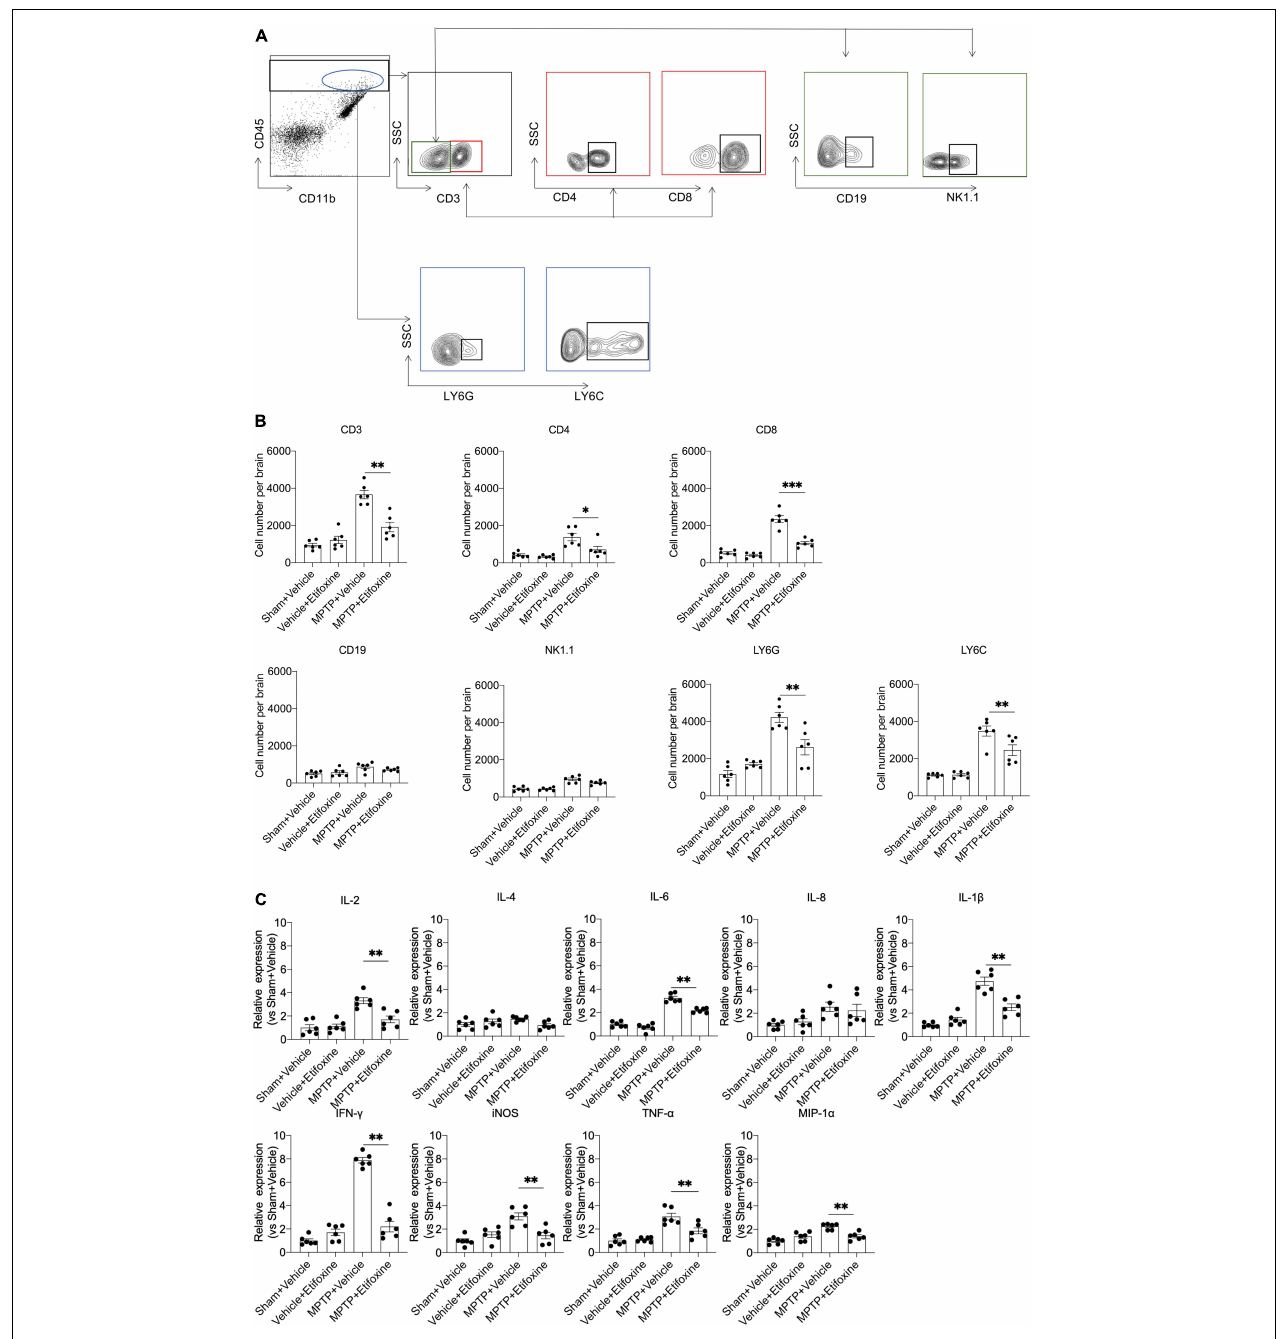
FIGURE 4 | Etifoxine decreased leukocyte infiltration and brain inflammation following MPTP treatment. C57BL/6 mice were administered etifoxine or vehicle immediately after saline or MPTP administration. After day 7, suspensions were prepared from substantia nigra and striatal tissues. (A) Flow cytometry plots showing the gating strategy for infiltrating leukocyte subsets, including T cells (CD45 high CD3 + ), CD4 + T cells (CD45 high CD3 + CD4 + ), CD8 + T cells (CD45 high CD3 + CD8 + ), B cells (CD45 high CD3 - CD19 + ), NK cells (CD45 high CD3 - NK1.1 + ), macrophages (CD45 high CD11b + LY6C + ), and neutrophils (CD45 high CD11b + Ly6G + ). (B) Quantification of infiltrating lymphocytes, macrophages, and neutrophils in the groups of mice receiving the indicated treatments. T cells: F (3,20) = 36.01, P < 0.001; CD4 + T cells: F (3,20) = 12.48, P = 0.01; CD8 + T cells: F (3,20) = 66.51, P < 0.001; B cells: F (3,20) = 4.483, P = 0.51; NK cells: F (3,20) = 24.73, P = 0.09; macrophages: F (3,20) = 32.11, P = 0.009; neutrophils: F (3,20) = 25.53, P = 0.002, ∗ P < 0.05, ∗∗ P < 0.01. (C) Bar graphs showing the mRNA expression of IL-2, IL-4, IL-6, IL-8, IL-1 β , TNF- α , MIP-1 α , iNOS, and IFN- γ in substantia nigra and striatal tissues from groups of mice receiving the indicated treatment. IL-2: F (3,20) = 17.61, P = 0.001; IL-4: F (3,20) = 2.701, P = 0.086; IL-6: F (3, 20) = 96.75, P < 0.001; IL-8: F (3,20) = 4.170, P = 0.94; IL-1 β : F (3,20) = 43.86, P < 0.001; TNF- α : F (3, 20) = 20.50, P = 0.003; MIP-1 α : F (3,20) = 17.81, P < 0.001; iNOS: F (3,20) = 12.82, P < 0.001; IFN- γ : F (3,20) = 111.7, P < 0.001. All data are presented as means ± SEM. ( n = 6 mice per group) ∗ P < 0.05, ∗∗ P <